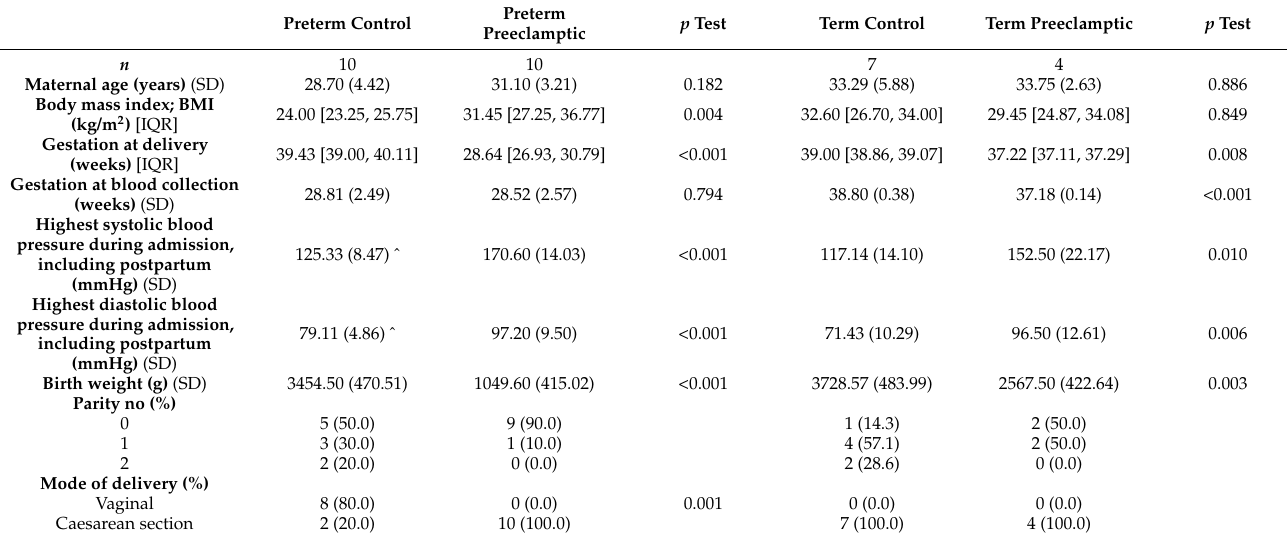
Table 1. Maternal clinical characteristics of serum samples from pregnancies complicated with preterm (early-onset) or term (late-onset) preeclampsia and gestation-matched normotensive control serum samples. Preterm